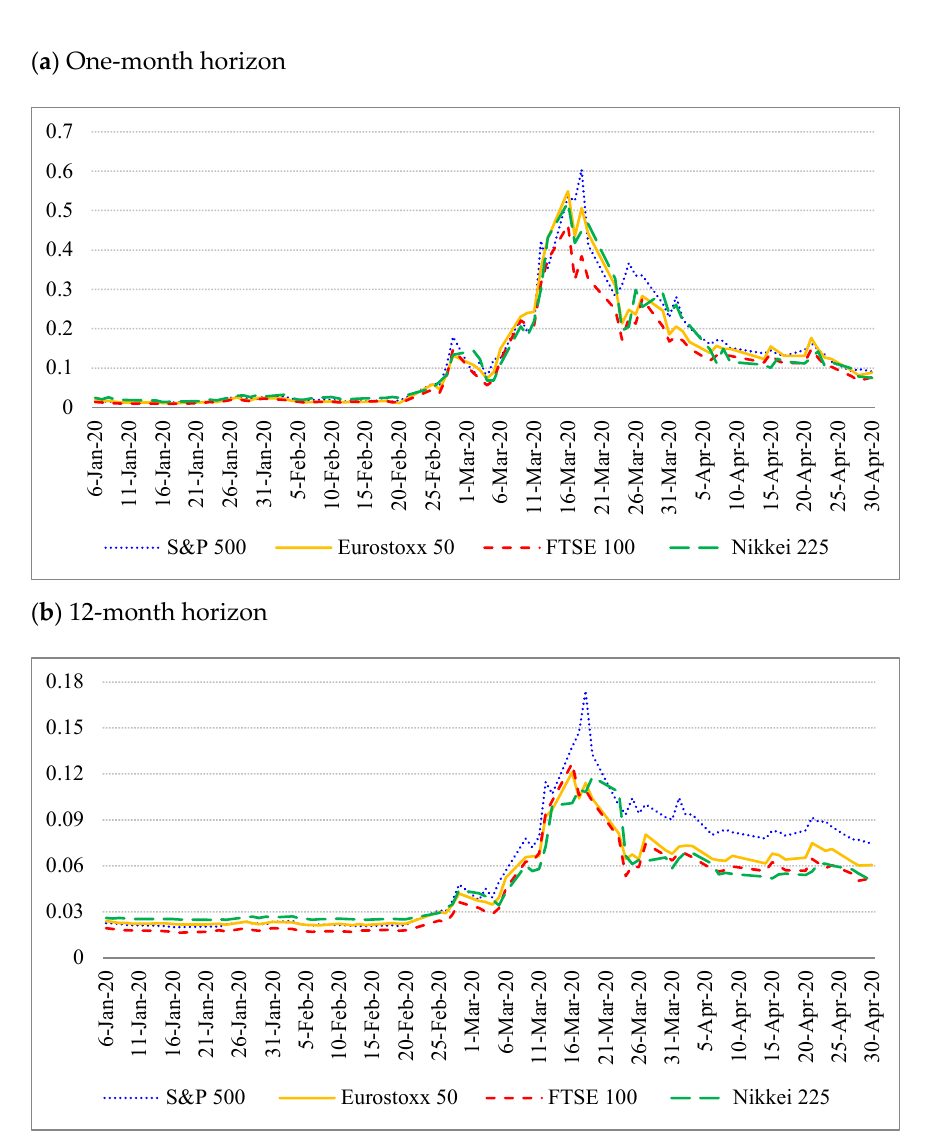
Figure 8. Expected Market Risk Premia: COVID-19 Crisis. This figure displays the time series behavior of the expected market risk premia estimated from option prices with four alternative underlying stock indexes: the S&P 500, Euro Stoxx 50, Nikkei 225, and FTSE 100. The expected risk premia are estimated daily following Martin (2017) and using options with maturities of one month ( a ) and 12 months ( b ). The sample period refers to the first wave of the COVID-19 pandemic and goes from January to April 2020. Table 7. Average Slope of the Term Structure of the Expected Market Risk Premia. Panel A: The Great Recession